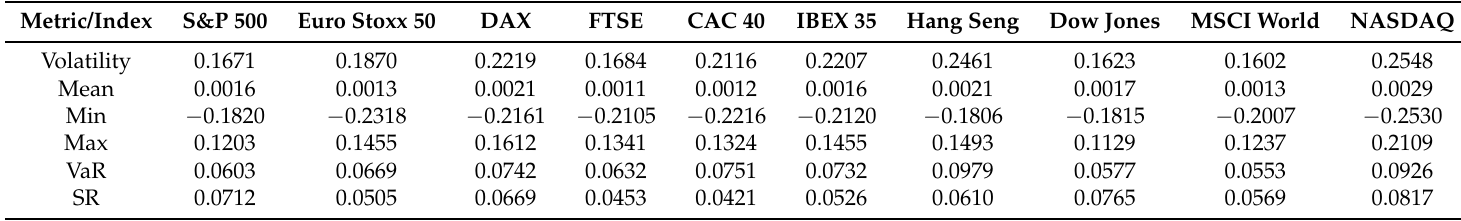
Table 2. This table shows the descriptive statistics of the equity indices used in our analysis. Volatility is calculated as per the ESMA 10-788 guidelines. The setup for the Value at Risk (VaR) is CI 0.99, 5 days (weekly returns). SR, Sharpe